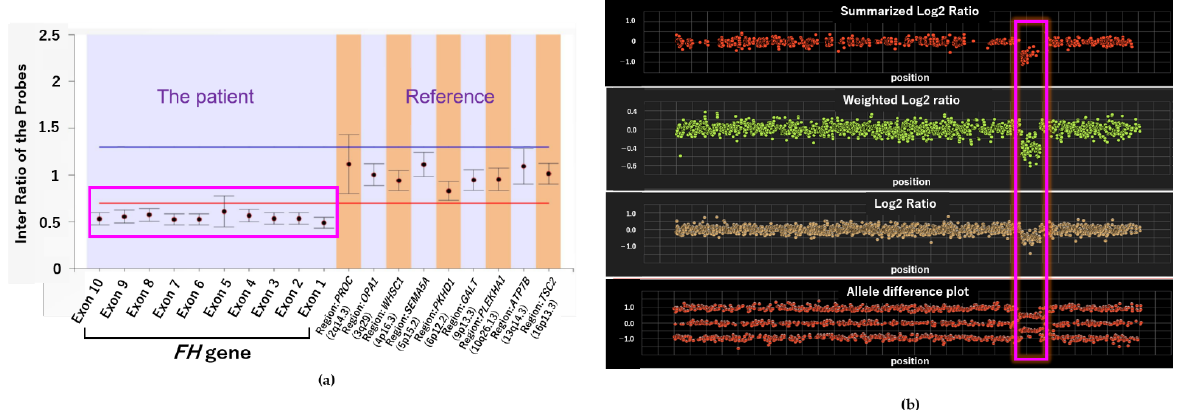
Figure 6. Analysis results of germline FH gene via multiplex ligation-dependent probe amplification (MLPA) and exon array. ( a ) Deletion of FH was confirmed by MLPA. ( b ) Result of exon array of chromosome 1.